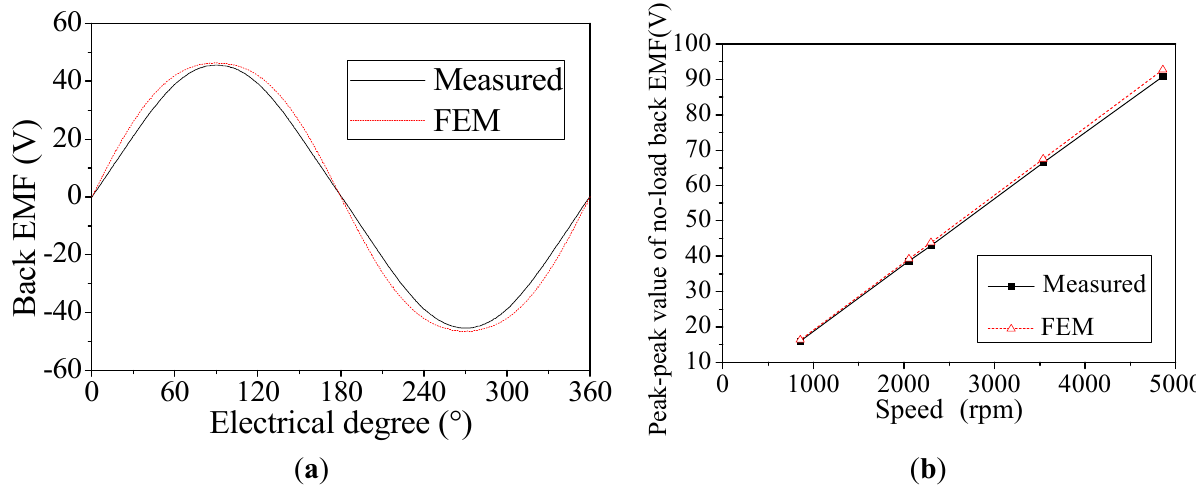
Figure 11. No-load Back EMF ( a ) at 4860 rpm and ( b ) versus different